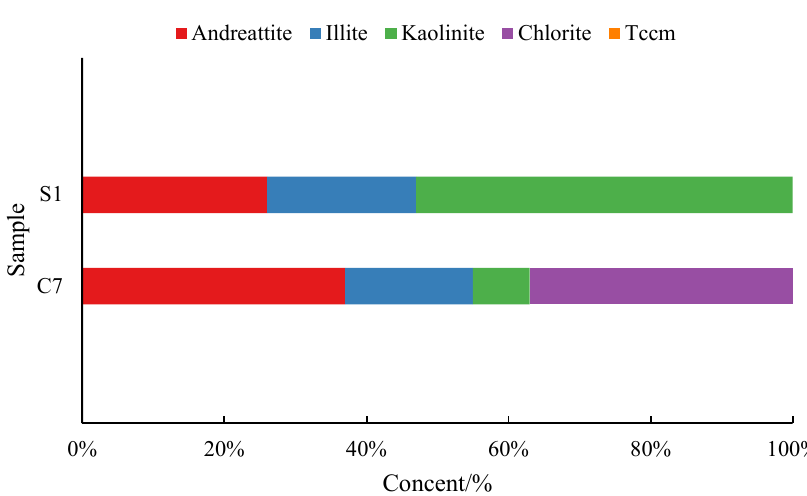
Figure 3. Clay mineral analyses of C7 and S1 shales.